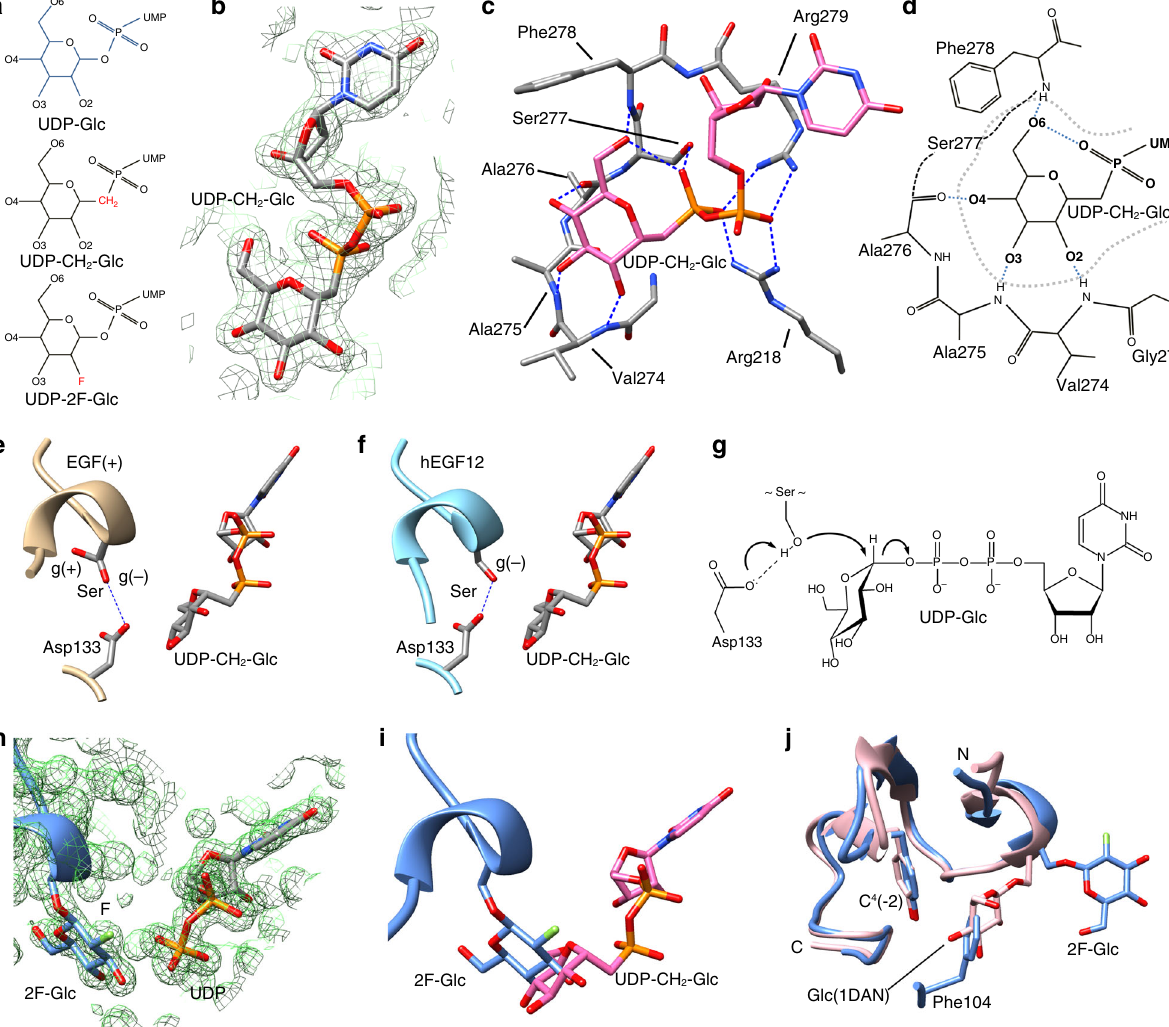
Fig. 3 Donor substrate analog complexes. a The natural donor substrate, UDP-glucose, and the two donor analogs used for co-crystallization. The UDP-2F- glucose was found to be transferred resulting in the POGLUT1/EGF(+)-2F-glucose/UDP complex. b Composite omit map (2 mF o – DF c) of the donor analog found in the 1.80 Å POGLUT1/EGF(+)/UDP-CH 2 -glucose complex, contoured at 1.50 RMSD (1.10 e Å − 3 ). A 3 Å radius electron density mask was applied around the UDP-CH 2 -glucose for clarity. c The glucose subsite showing the hydrogen bonds. Two critical Arg residues interacting with both phosphates are also shown. d All hydrogen bonds involving the glucose moiety of UDP-CH 2 -glucose. e The EGF(+)/UDP-CH 2 -glucose complex showing the two rotamers (gauche (+) and gauche ( − )) observed for the serine. f Superimposition of hEGF12 with the EGF(+)/UDP-CH 2 -glucose complex aligned on POGLUT1. g The S N 2 catalytic mechanism of POGLUT1. h Composite omit map (2 mF o – DF c) of the 1.31 Å POGLUT1/EGF(+)-2F-glucose/UDP product complex, contoured at EGF(+)-2F-glucose ( blue ) product and the UDP-CH 2 -glucose donor analog ( magenta ). j Superimposition of the EGF(+)-2F-glucose ( blue ) and glucosylated hF7EGF1 ( pink ; PDB: 1DAN). POGLUT1 residue Phe104 interacts with the conserved aromatic C 4 ( − 2) residue in all POGLUT1/EGF